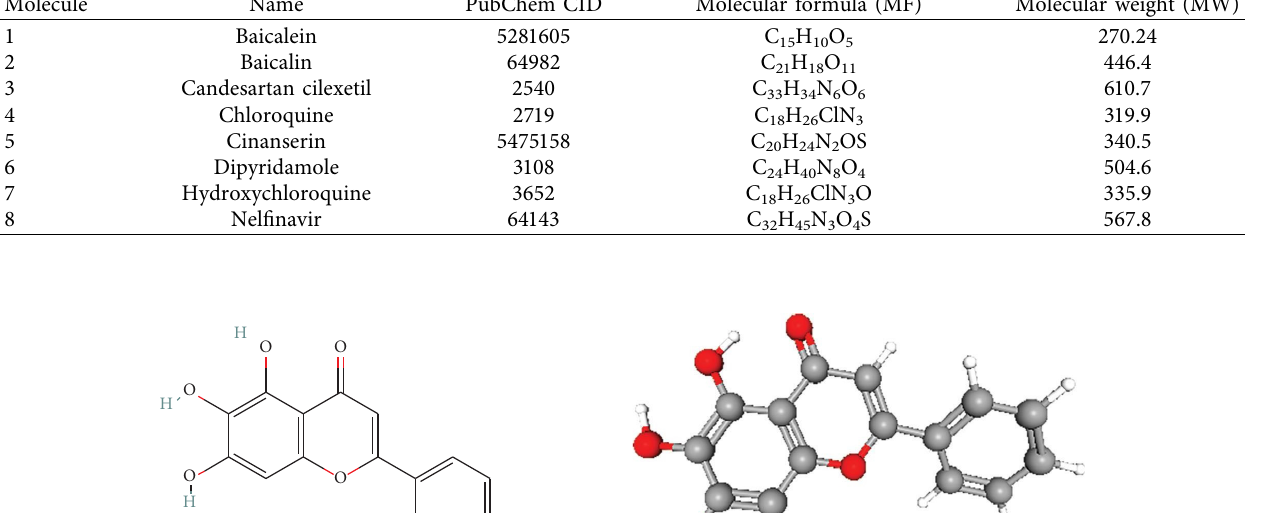
Table 1: Basic information on the anti-SARS-CoV-2 M pro compounds retrieved from the PubChem library database.